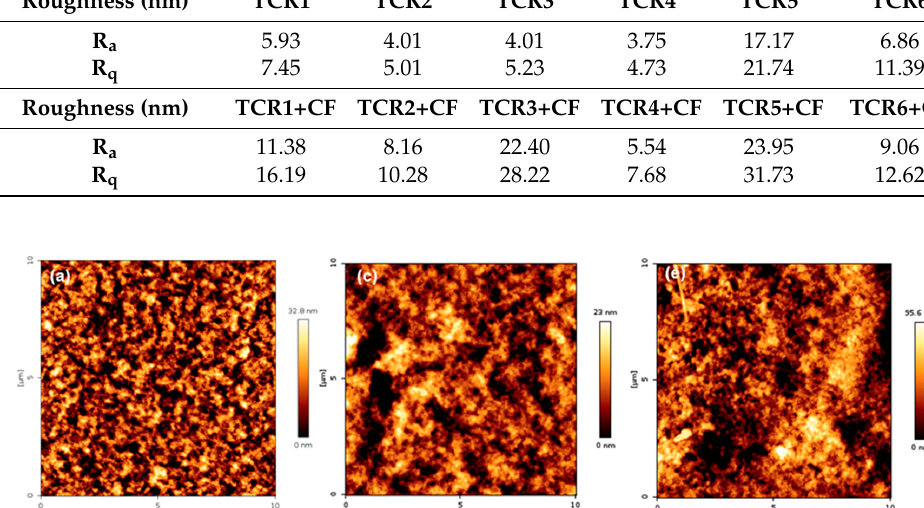
Table 3. Calculated values of the arithmetic average roughness ( R a ) and the root mean squared roughness ( R q ) for the TCR series and TCR + CF nanocomposite sample.